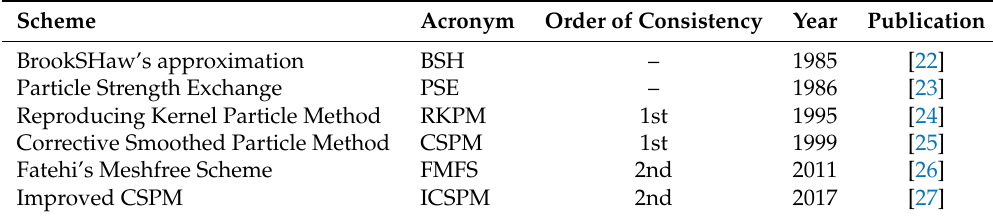
Table 1. Summary of the methods implemented in this